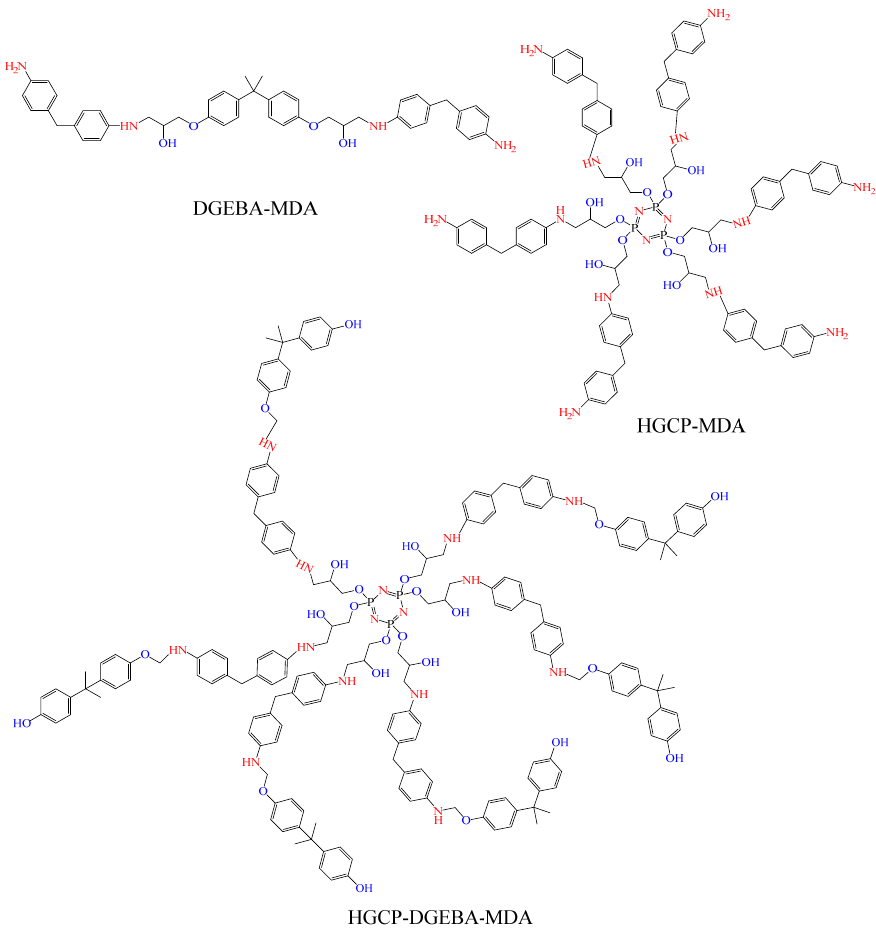
Figure 4. Epoxy resins (DGEBA, HGCP, and their mixture) crosslinked by MDA.